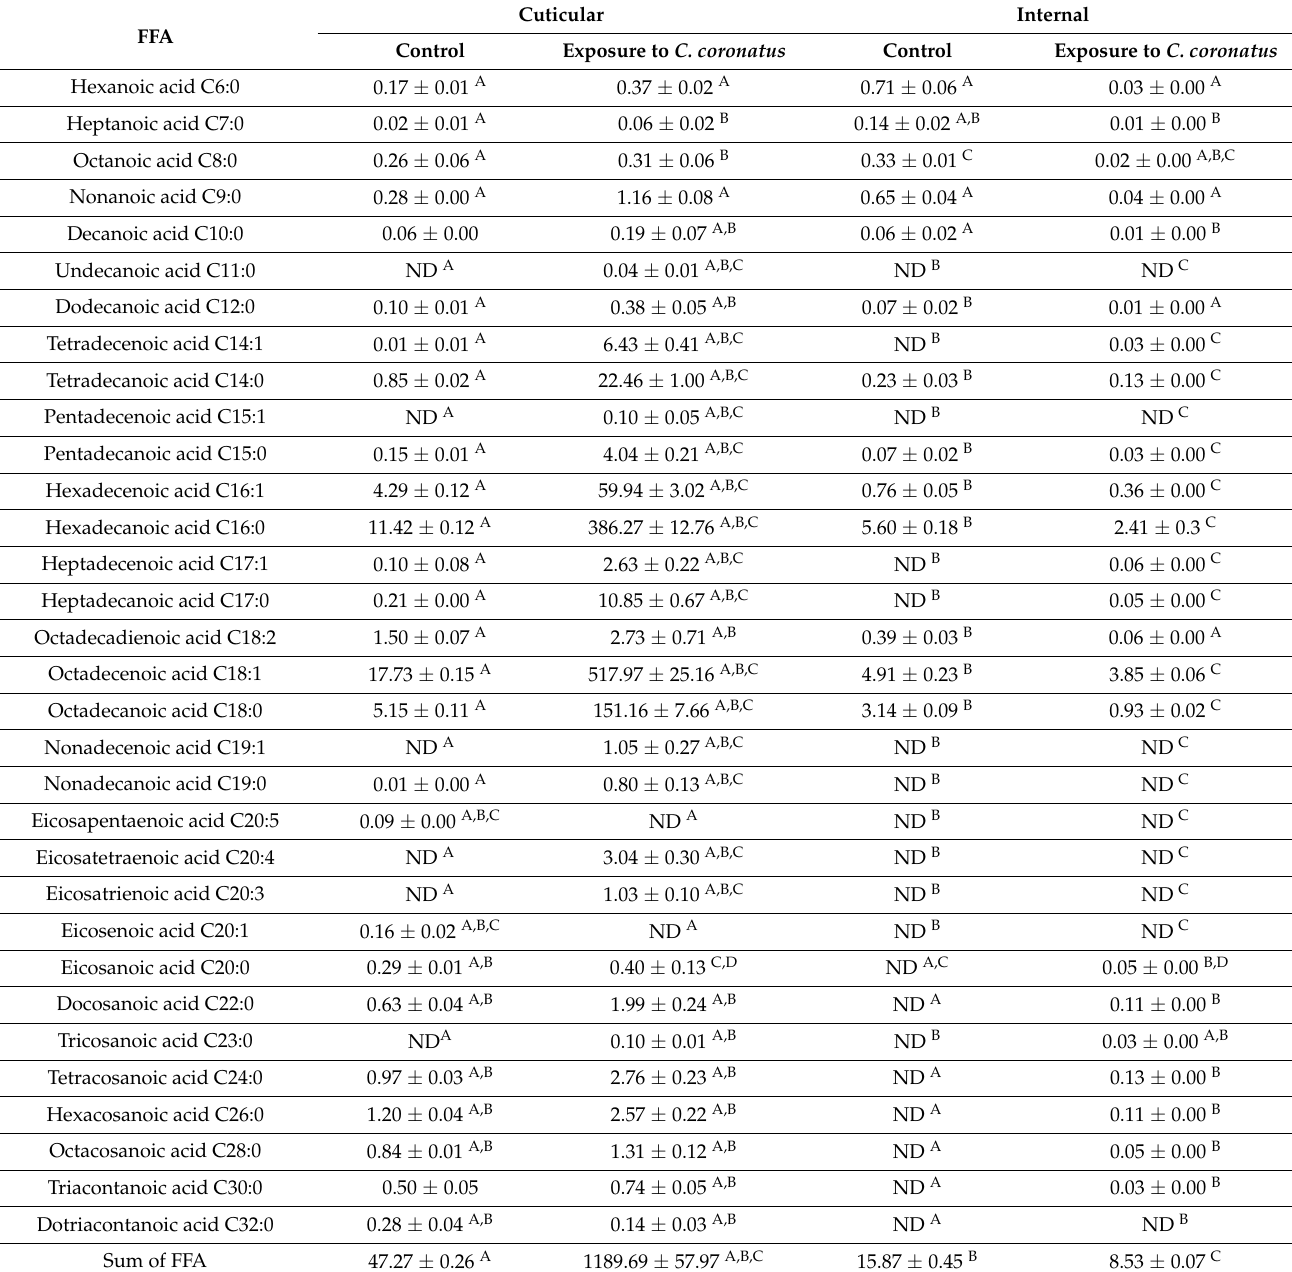
Table 3. Fatty acid content of the cuticular and internal lipids extracted from the pupae of Sarcophaga argyrostoma ( µ g/g of insect body ±